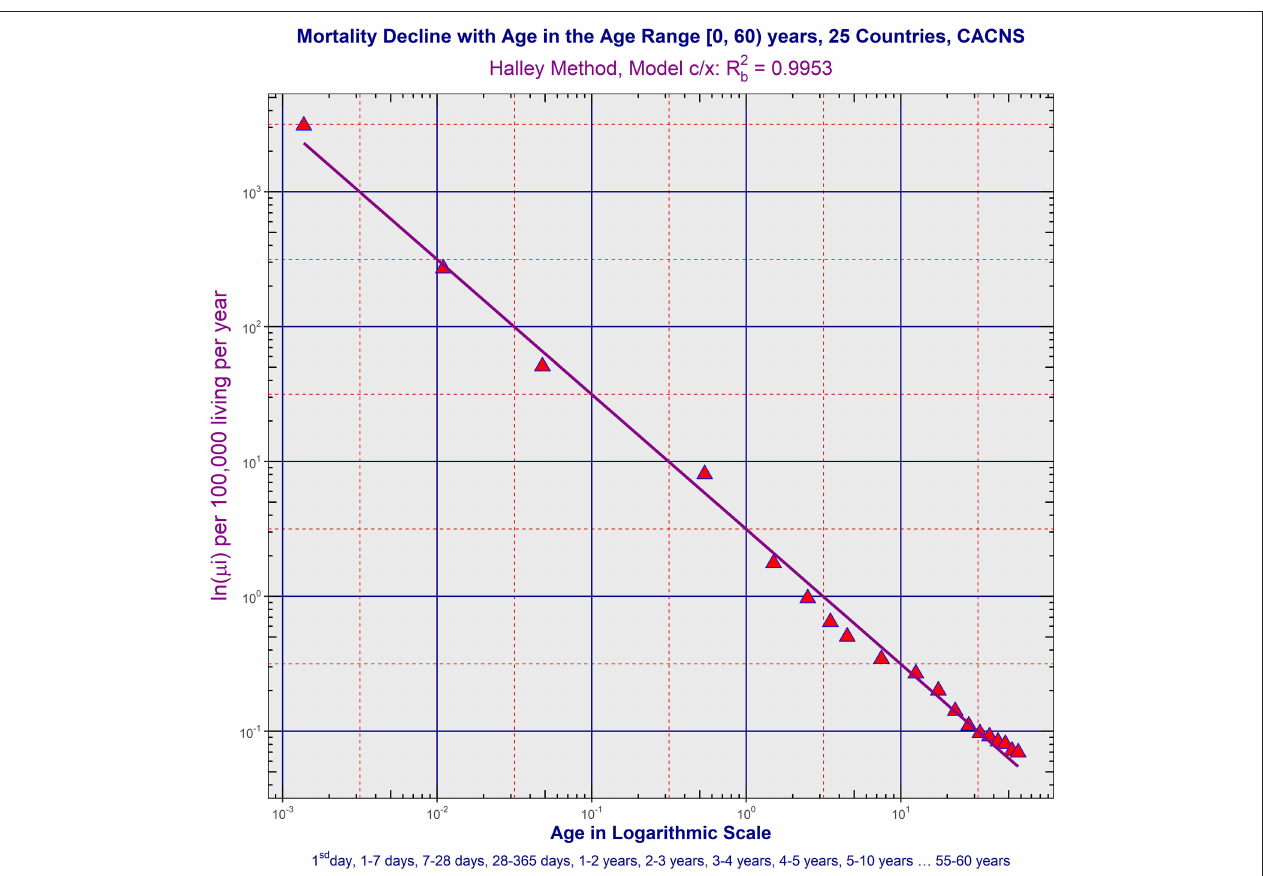
FIGURE 2 | Age trajectory of CACNS in P25.